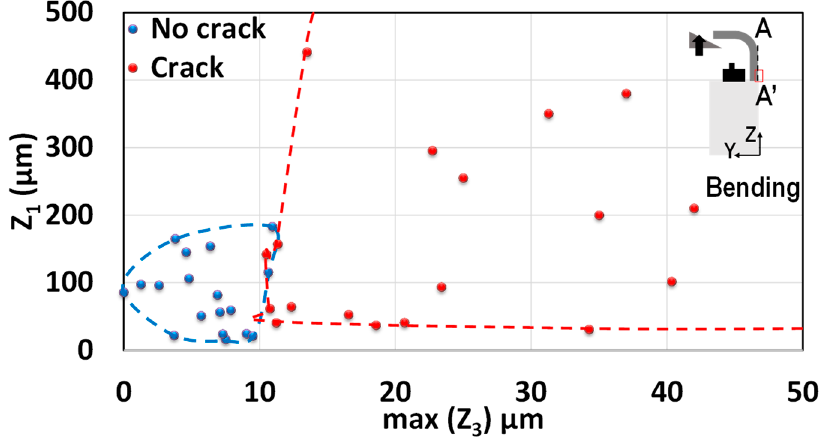
Figure 4. Relation between observed gaps and cracking after bending. The admissible gaps are shown in blue. Lateral gaps larger than 10 µm systematically lead to cracking. in blue. Lateral gaps larger than 10 µ m systematically lead to